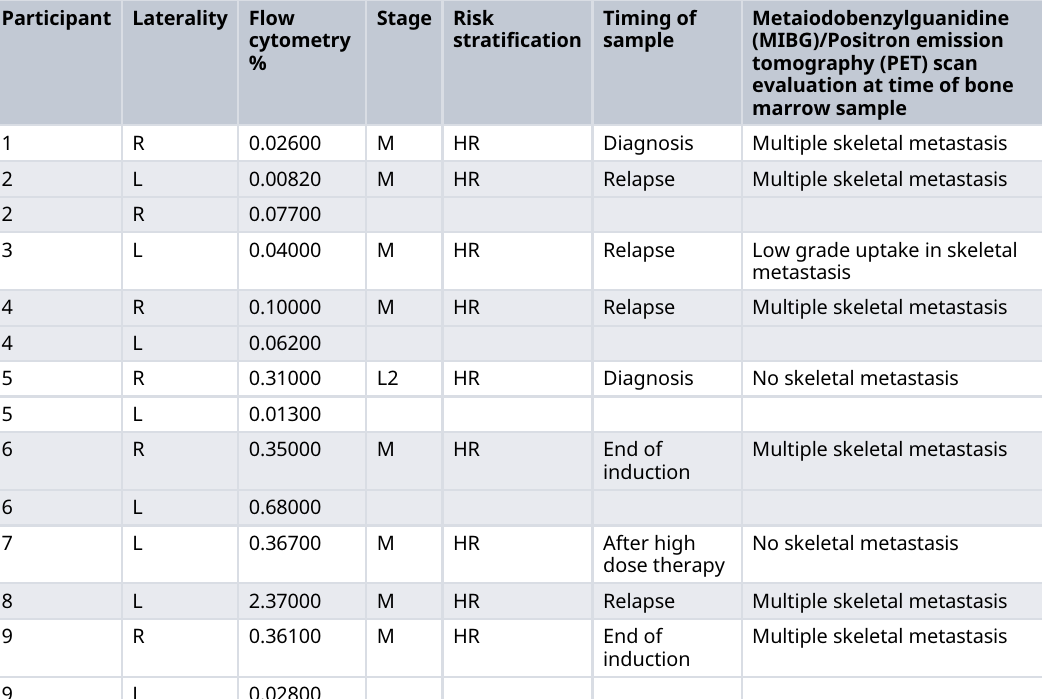
Table 1. Exclusively flow cytometry positive cases. L2 is localised unresectable disease and M denotes metastatic disease. Participant Laterality Flow